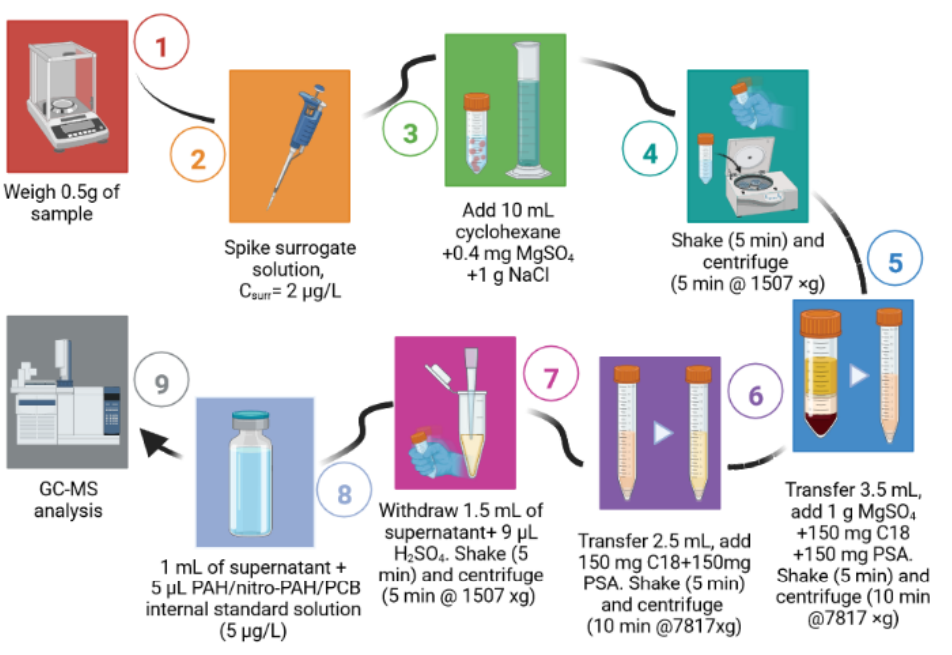
Figure 1. Schematic representation of the optimized QuEChERS method for the analysis of PAHs, nitro-PAHs and PCBs in tomatoes.